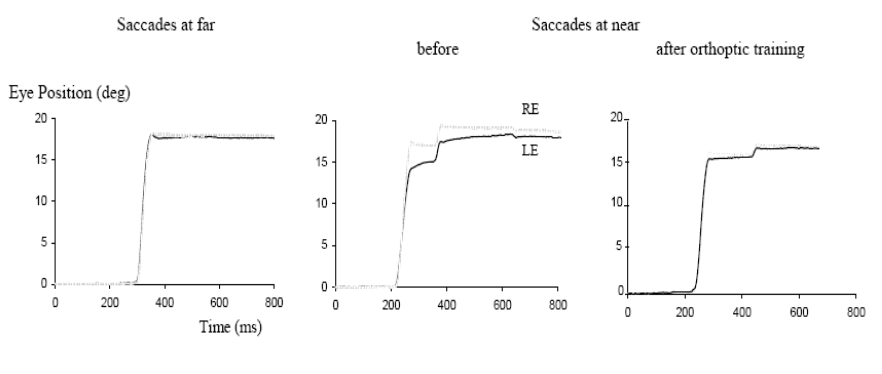
Figure 3. Binocular recordings of saccades from a child with vertigo recorded at far and at near distance before and after or- thoptic training. The grey trace is the right eye, the dark trace is the left eye; target-LED appeared at time zero.